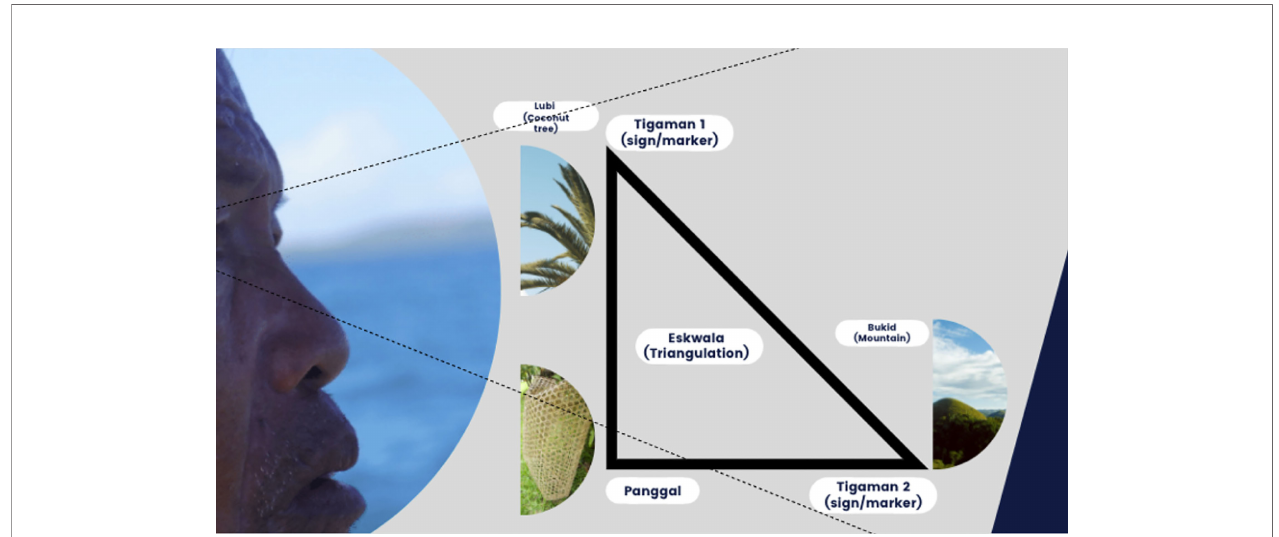
FIGURE 4 | Eskwala (Triangulation) as Indigenous Geo-spatial Knowledge. Tatay Doning looks at the tigaman (markers/signs) on land to recover his Panggal fi shing trap. He locates his trap by scanning the land forms from where he is located on the waters and where the Panggal was dropped (Original fi gure by Dennis Gupa; redesigned by the authors using Canva.com, 2021).